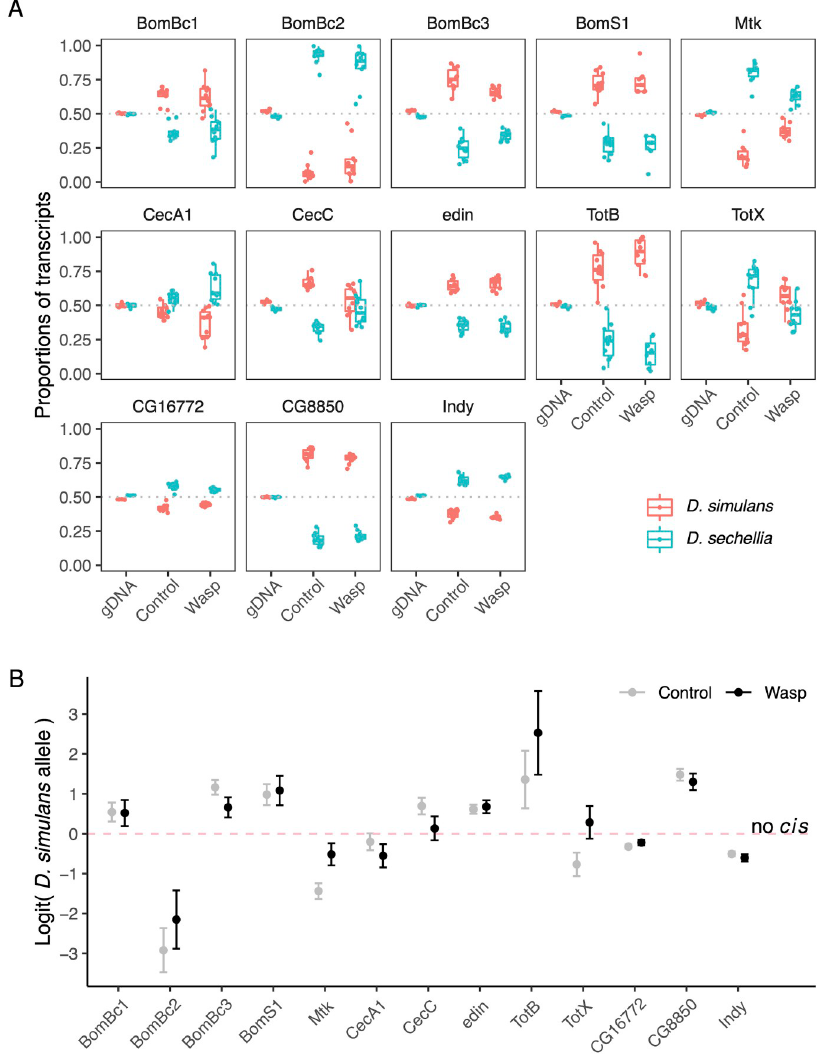
Fig 6. Cis regulatory divergence in humoral immunity genes. Transcripts were amplified by PCR from F1 hybrids between D. simulans and D. sechellia , and the PCR products Illumina sequenced. RNA was extracted from whole larvae that were uninfected (control) or immune challenged (wasp). Genomic DNA (gDNA) was included to check there were no biases towards one allele. (A) The proportion of reads from the two alleles. (B) The natural log of the odds (logit) that a transcript is from the D. simulans allele. Error bars are 95% confidence intervals on model coefficients. Fly larvae were immune-challenged by injecting them with oil droplets containing wasp homogenate. The horizontal dashed line ( y = 0.5) signifies that there is no cis- regulatory divergence between the two species.